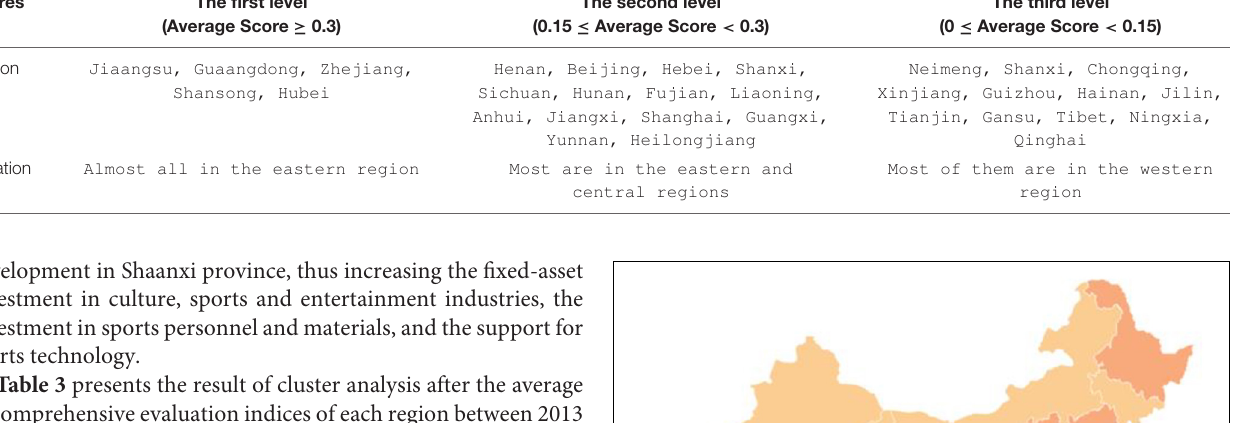
The third level (0 ≤ Average Score < 0.15)